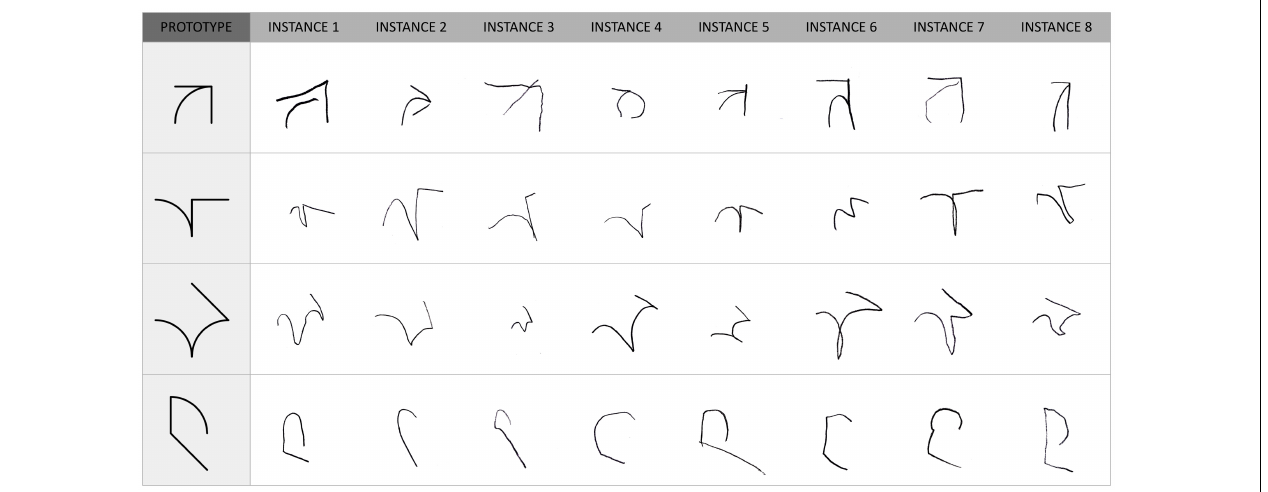
were displayed in black against a white background. Categories